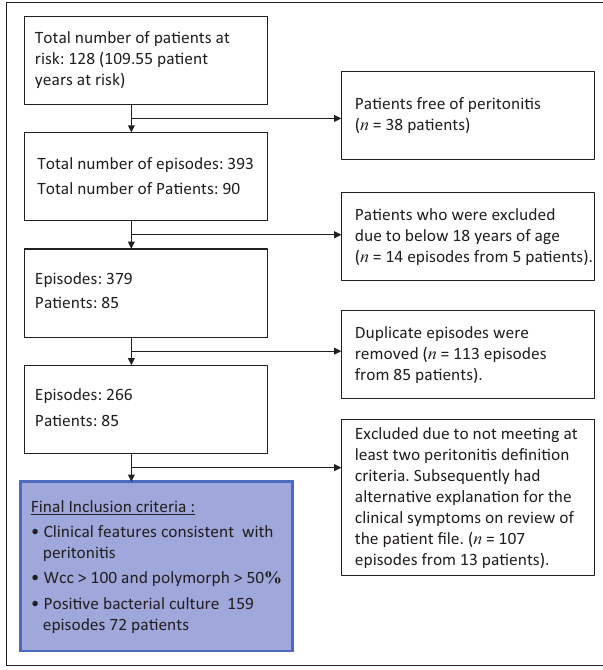
wcc, white cell count. FIGURE 1: Flow diagram showing exclusion